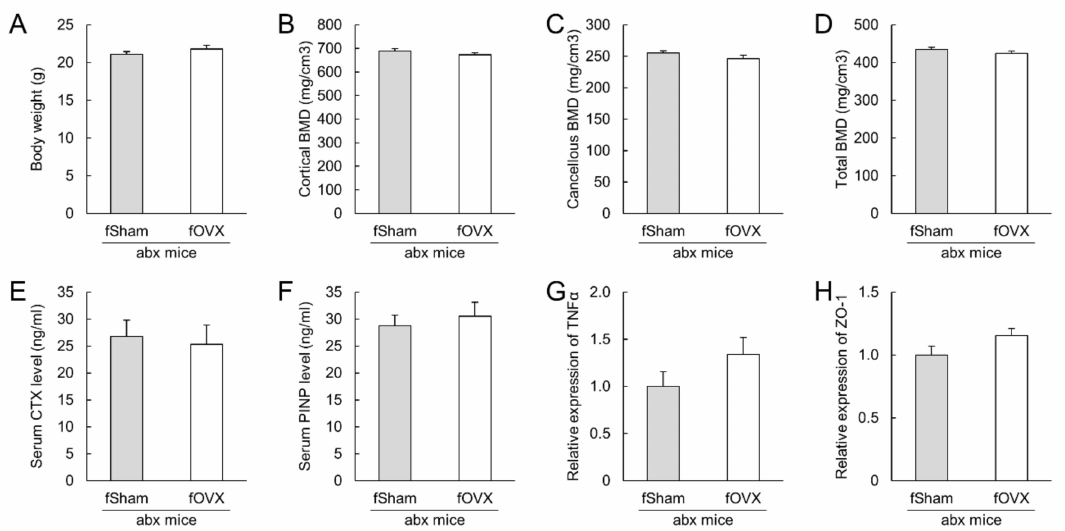
Figure 4. Fecal microbiota transplantation from ovariectomized (OVX)- and sham- mice to antibiotic-treated mice. Antibiotic- treated mice were orally administered cecal luminal contents of sham or OVX mice three times per week for four weeks. ( A ): Body weight at sacrifice ( B – D ): Tibial bone mineral density. ( E , F ): Serum bone formation marker ( E ) and serum bone resorption marker ( F ). ( G , H ): Relative mRNA expression of TNF α ( G ) and ZO-1 ( H ). N = 8–9 per group. BMD: bone mineral density, CTX: C -terminal telopeptide of collagen, LPS: lipopolysaccharide, PINP: procollagen type I N -terminal propeptide,